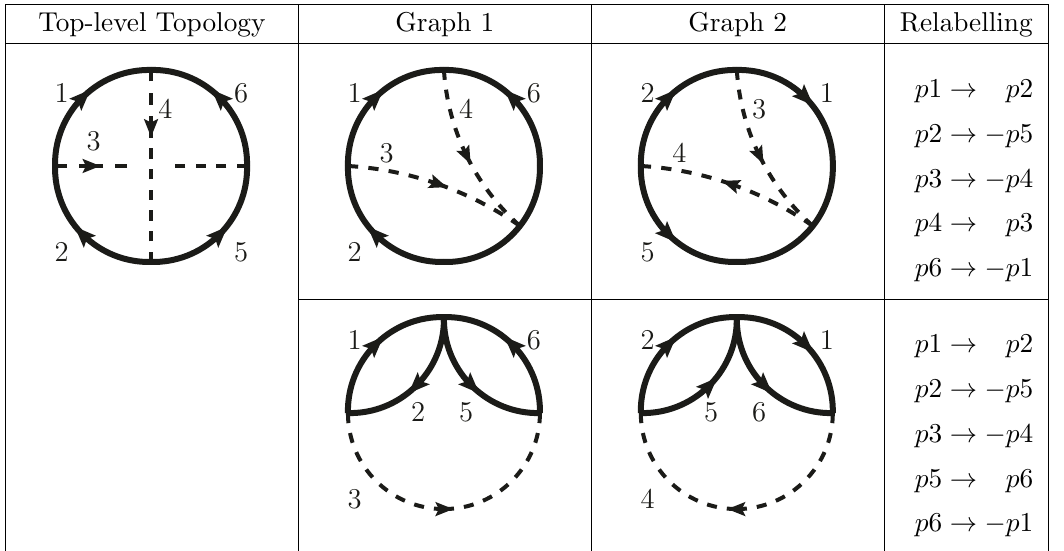
Table 1 . Graphs 1 and 2 are derived from the Top-level Topology, with di(cid:11)erent lines missing. This yields di(cid:11)erent, but equivalent, graphs. Line momenta are relabelled to make this equivalence manifest; we show the replacements required to map Graph 1 onto Graph 2. The arrows denote the direction of momentum